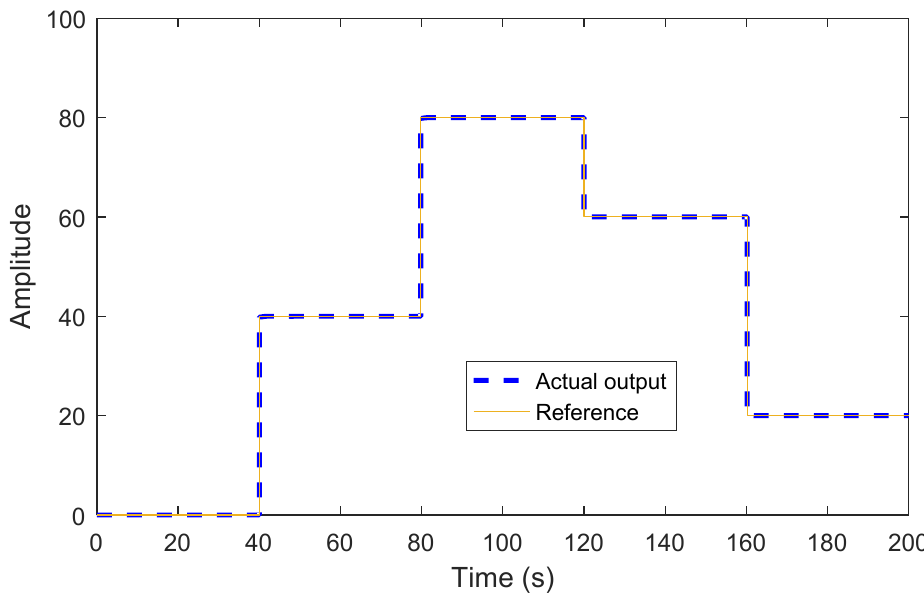
Figure 6. Response of SLSSO-based controller for variable step input for loop I.